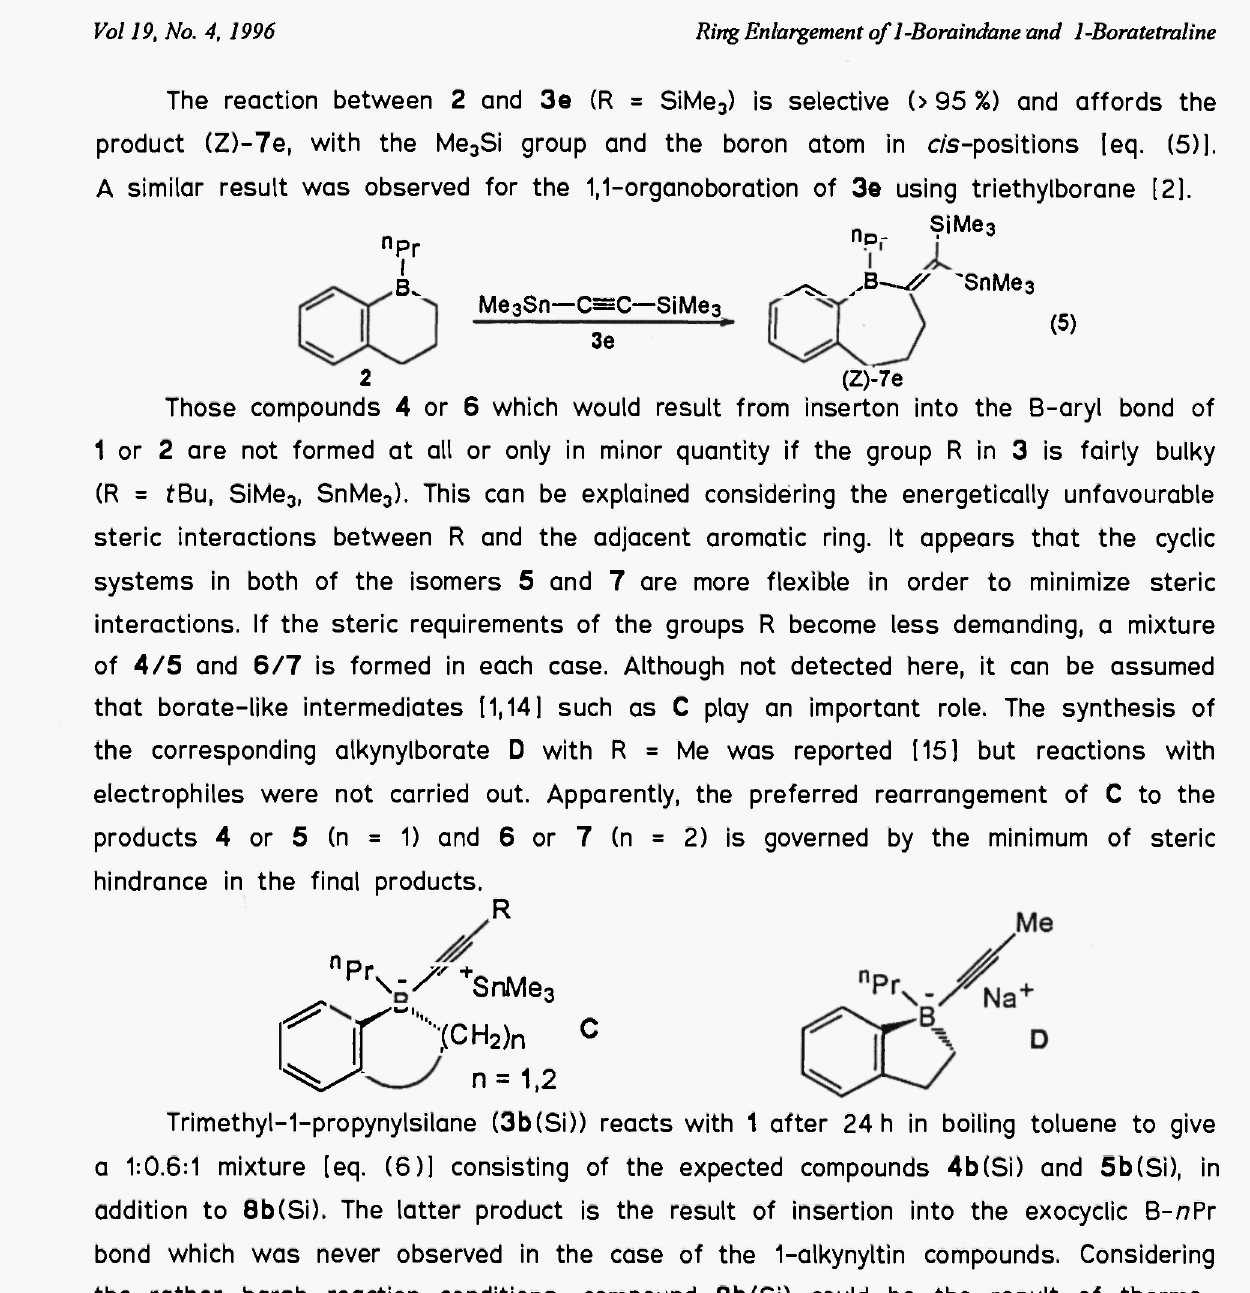
(E)-3-diethylboryl-2-trimethyl-